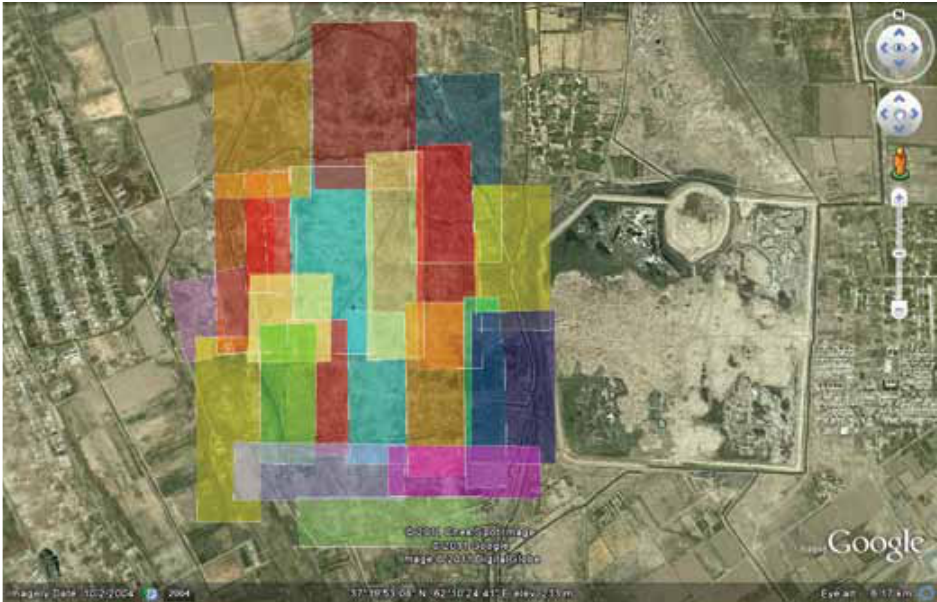
Fig. 10: Coverage of APs over Merv, with each coloured box representing a single flight. Note the larger area covered in the northern part of the survey, when flying at c.105m and captur- ing 4cm/pixel resolution images, as compared to the smaller survey grids to the south, at the 2cm/pixel